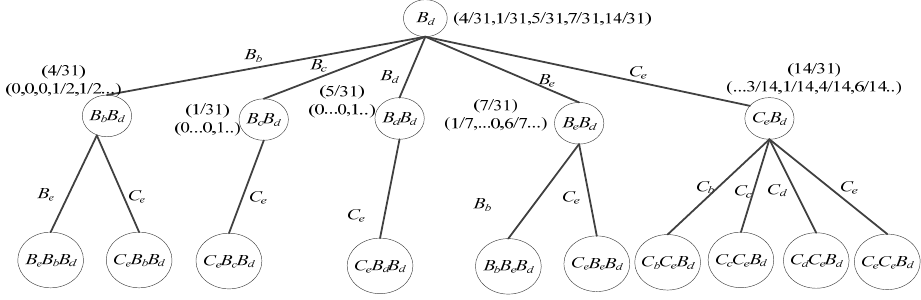
Figure 9. wPST tree representations for event B d .